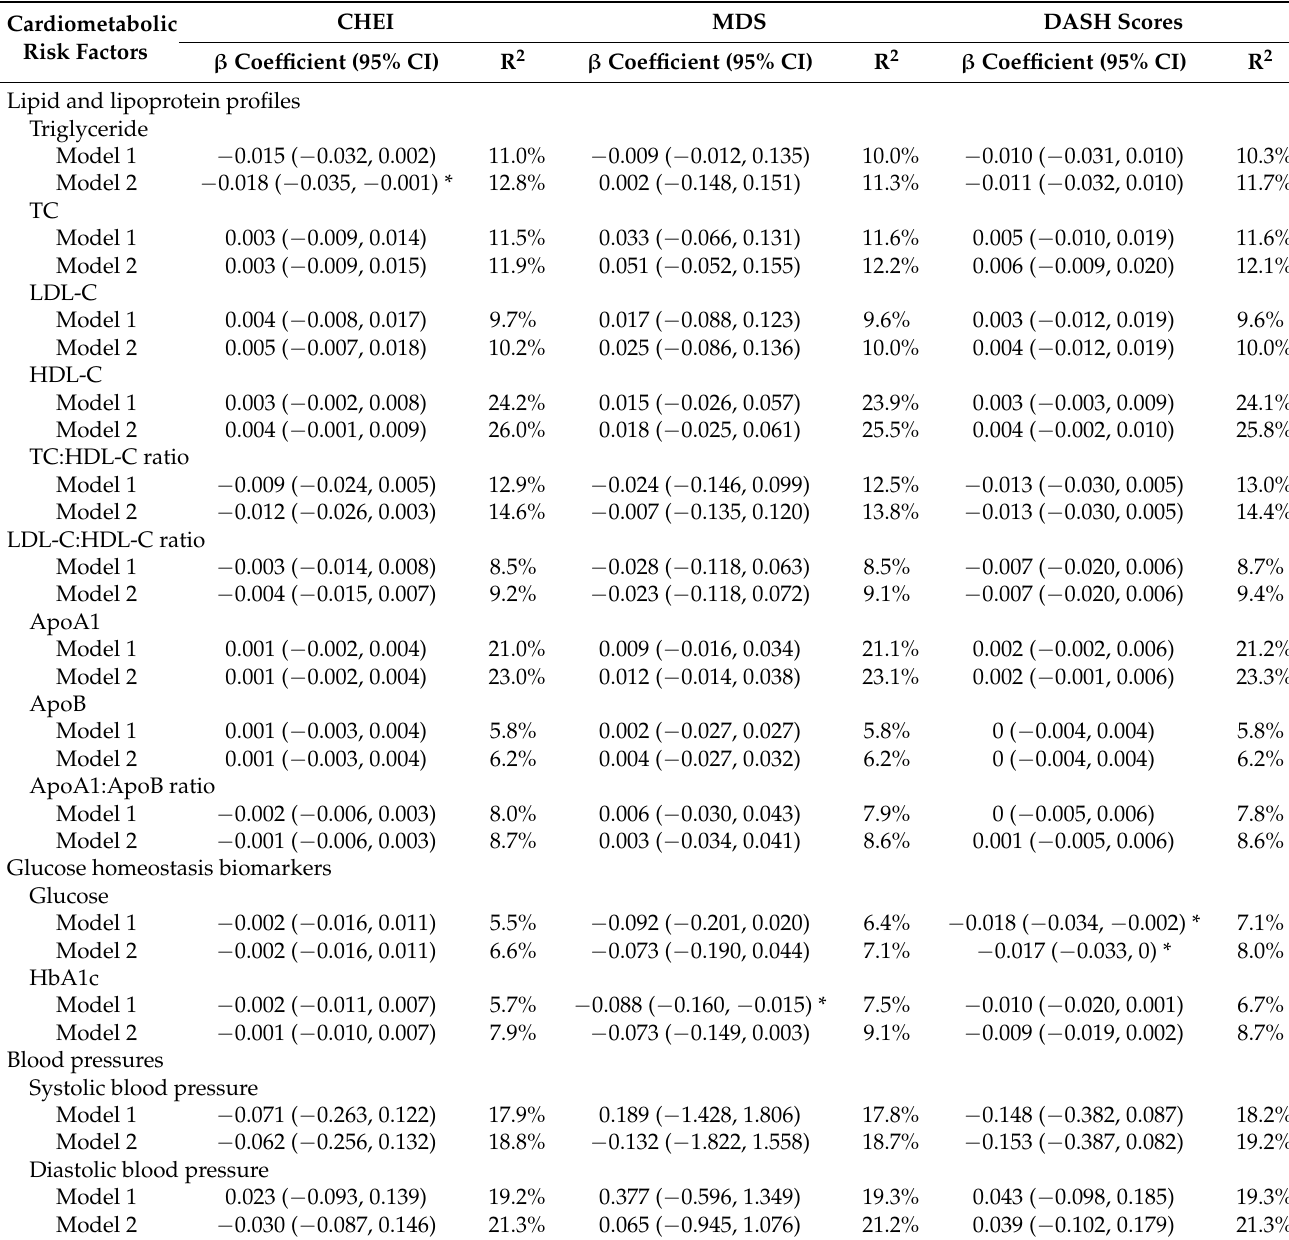
Table 6. Associations between CHEI, MDS, and DASH scores and cardiometabolic risk factors among 269 Chinese participants with hyperlipidemia 1,2